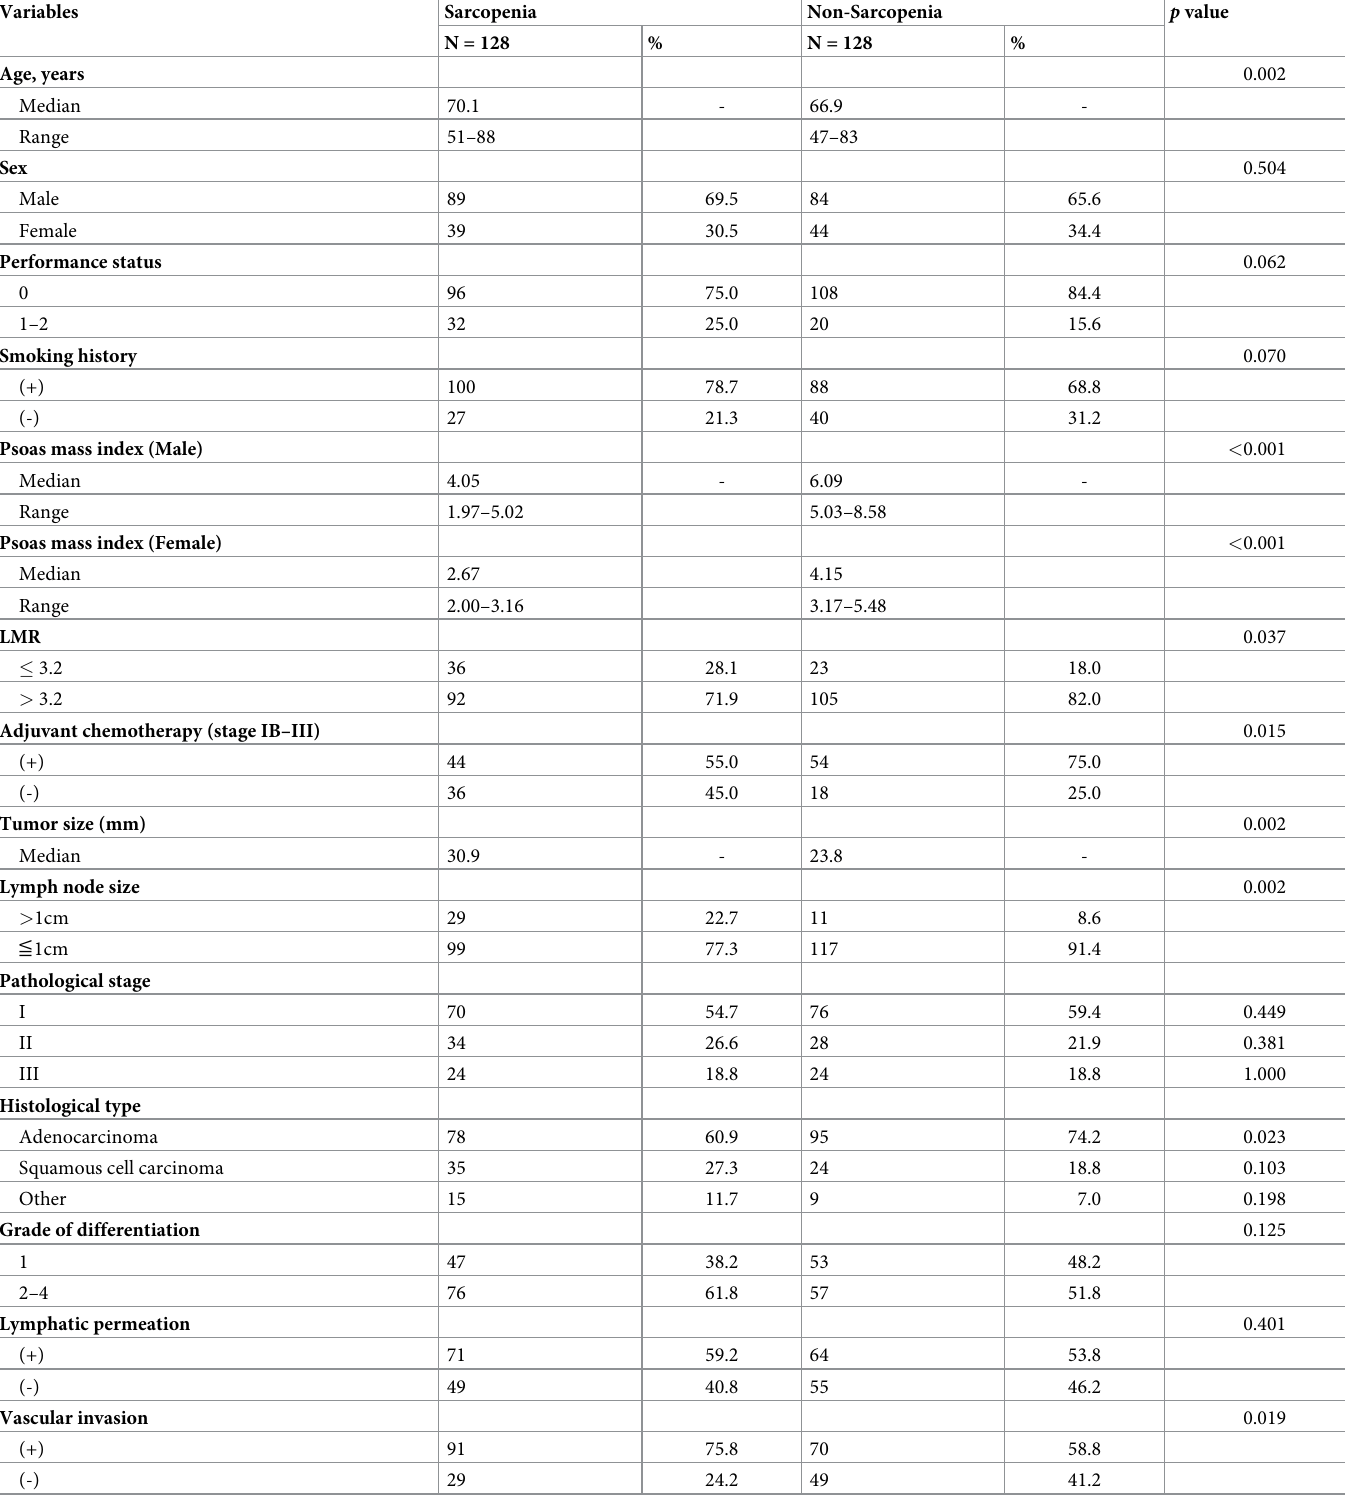
Table 1. Characteristics of patients with and without